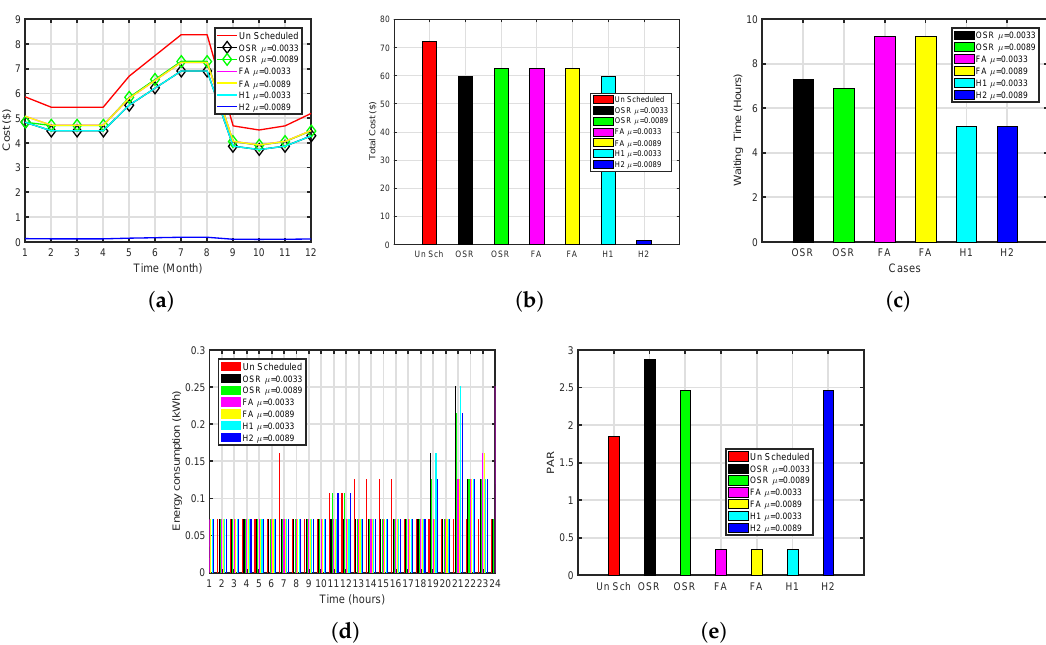
Figure 12. Hybrid Plots for Refrigerator (OSR-FA). ( a ) Monthly Cost of Refrigerator (OSR-FA), ( b ) Total Cost of Refrigerator (OSR-FA), ( c ) Waiting Time of Refrigerator (OSR-FA), ( d ) Energy Consumption of Refrigerator (OSR-FA), ( e ) PAR of Refrigerator (OSR-FA).